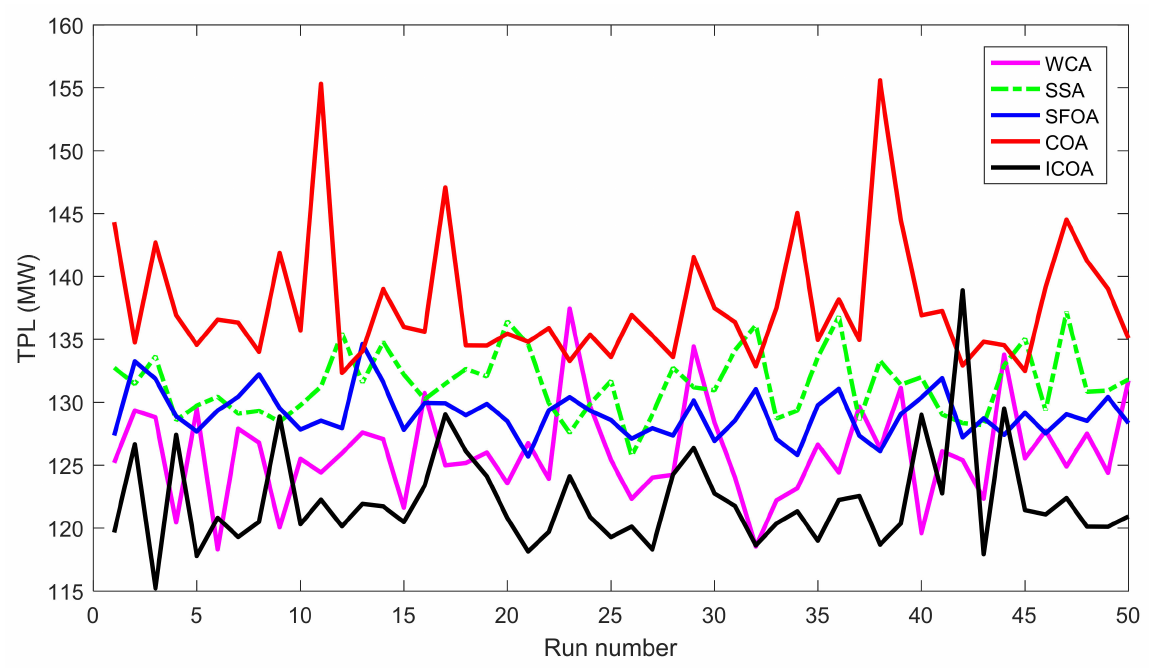
Figure 9. TPL of 50 runs obtained by different methods for the IEEE 118-bus system.